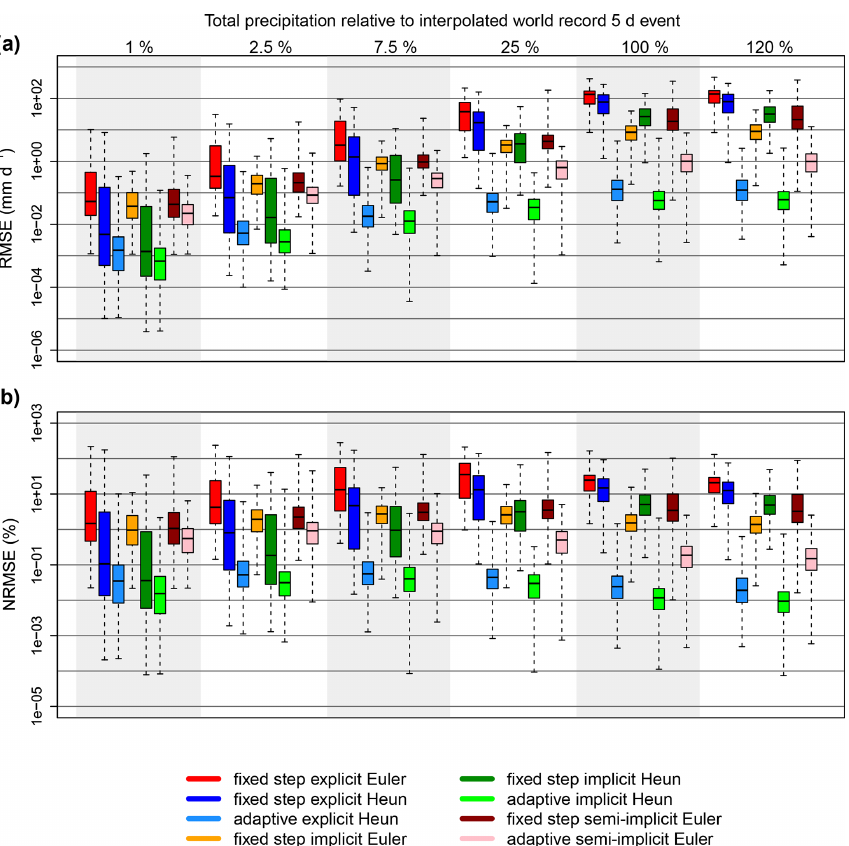
Figure 5. Box plots showing the errors (RMSE shown in a and NRMSE shown in b ) associated with associated with each numerical technique for 5d precipitation events of increasing intensity, where the intensity is represented as a percentage of the interpolated world record 5d event intensity. The solid black line in each box is the median error, the boxes extend to the 25% and 75% quantiles, and the whiskers extend to extreme values. All adaptive methods use the FUSE default error tolerances. Heun methods are second order, whereas Euler methods are first order. The model runs represented in this figure are generated across 20 parameter sets, five model structures, and three spin-up